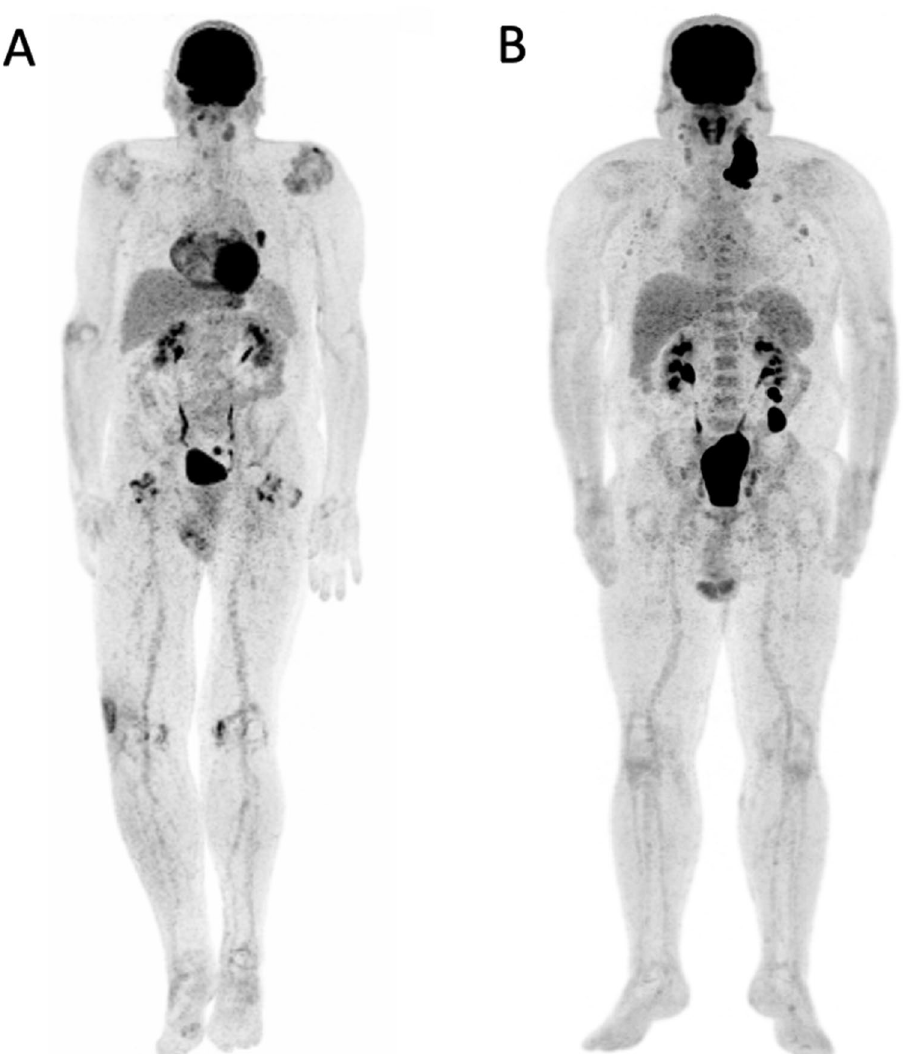
Figure 1. The maximum intensity projection PET images from two subjects. ( A ) Alive at the time of analysis, showed an inguinal right lymph node and a left pulmonary nodule (total MTV 3 cm 3 ) with low LZE (− 4194) and ( B ) dead at the time of analysis, showed cervical, axillary, celiac, mesenteric, iliac lymph nodes (total MTV 50,5 cm 3 ) with high LZE (58,336). Total MTV: total metabolic tumoral volume, LZE: long zone